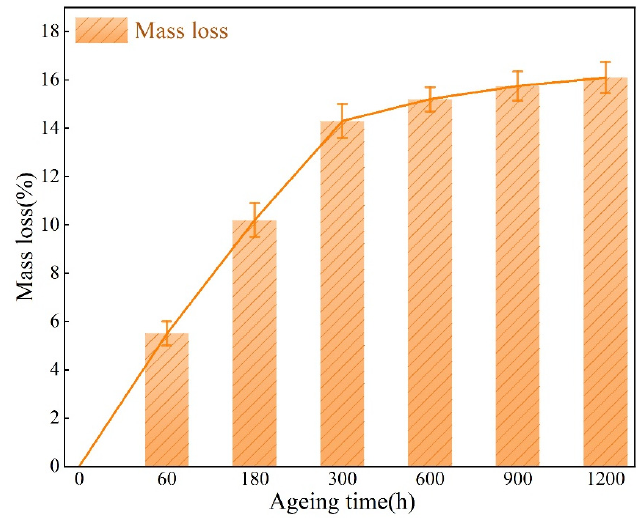
Figure 6. The relationship of mass loss rate of aged epoxy coatings with time.